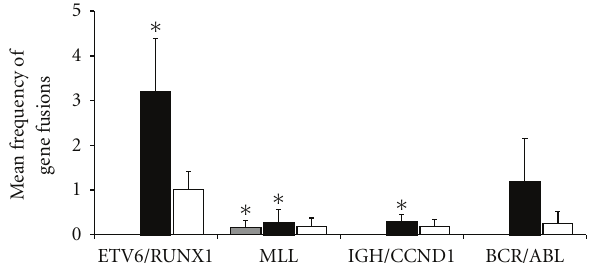
Figure 1: Mean frequency of gene fusions in peripheral lympho- cytes from ALL survivors analyzed months or year(s) after therapy completion (black boxes) and healthy donors (white boxes). In the case of MLL fusions the group of survivors was subdivided into patients treated with topoisomerase II inhibitors (grey box) and patients treated without the inclusion of such drugs in the treatment protocol (black box). ∗ P < . 05. Data for ETV6/RUNX1 and MLL was taken from Brassesco et al. [20] and [19],